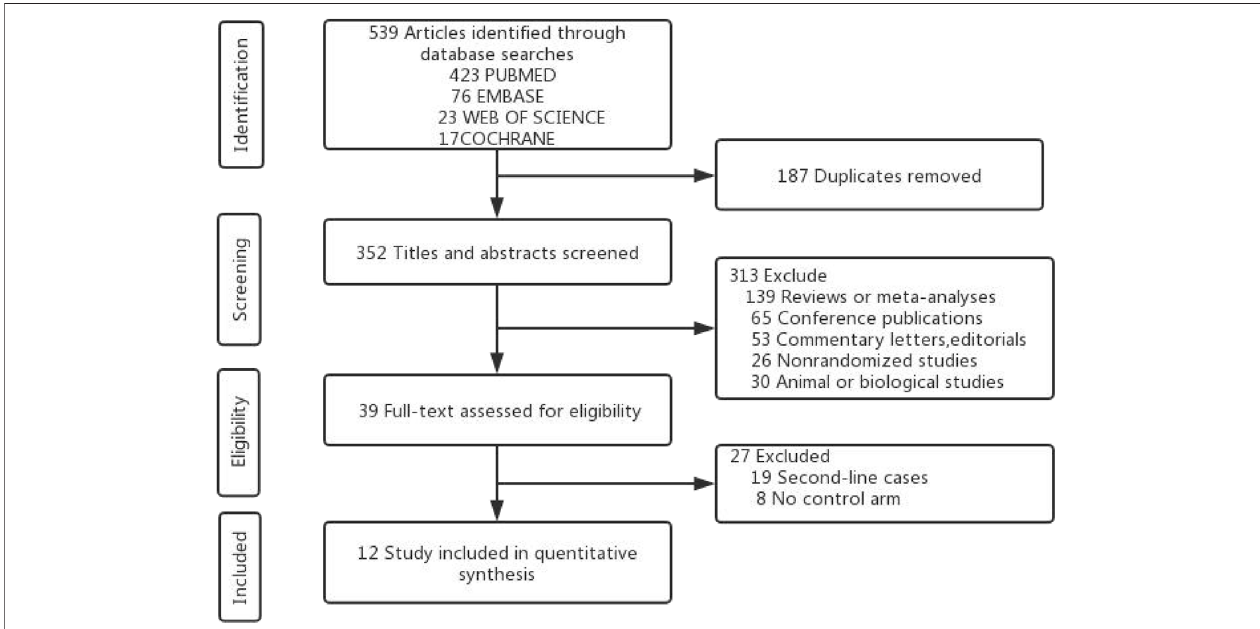
FIGURE 2 | Flowchart of the systematic search PRISMA fl ow